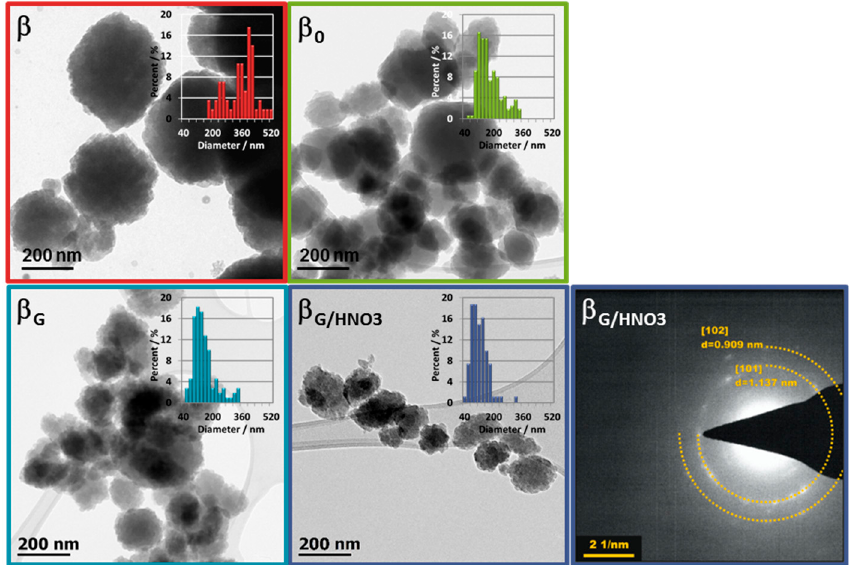
Figure 1. XRD patterns ( A ) and N 2 adsorption–desorption isotherms with pore size distribution (inset) ( B ) of the studied samples ( β HIERARCHICAL sample added for comparison [5]).